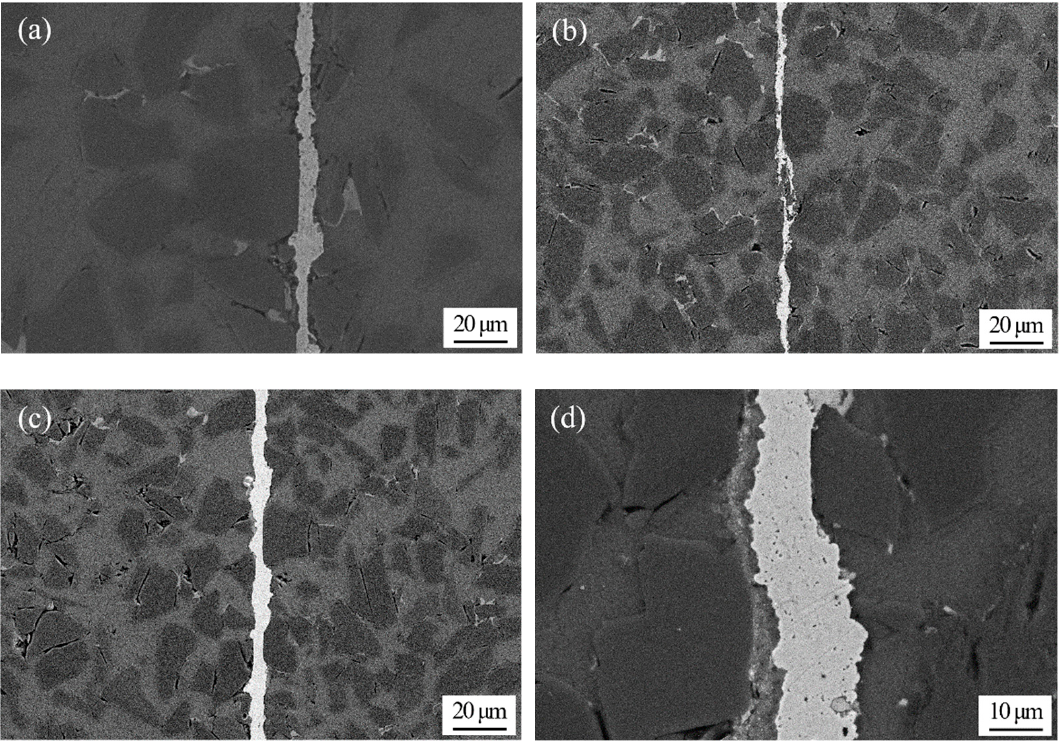
Figure 5. Scanning electron microscope (SEM) micrographs of the joint made using liquid gallium with nano-copper particles at: ( a ) 460 ◦ C; ( b ) 480 ◦ C; and ( c , d ) 450 ◦